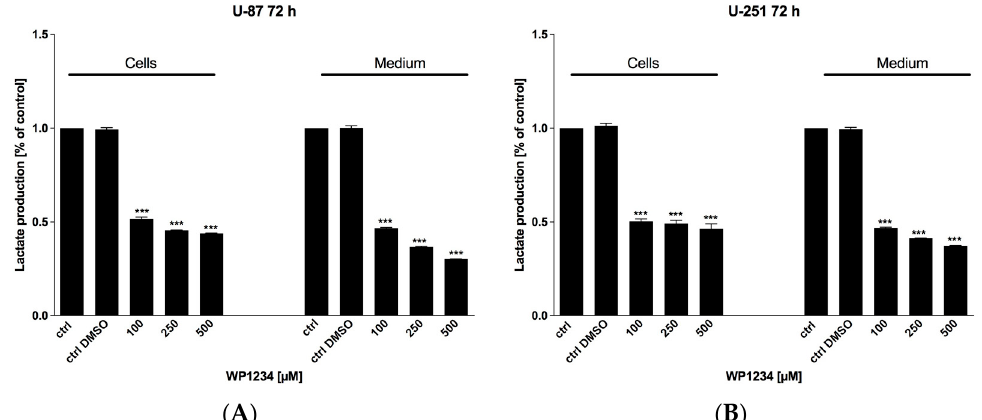
Figure 6. Intra- and extracellular (medium) lactate level after 72 h treatment with various concentrations of WP1234 (100–500 μ M) in ( A ) U-87 and ( B ) U-251 cells. Significant differences between the treatment and control (untreated cells) means are indicated by * p < 0.05, ** p < 0.01, *** p < 0.001.